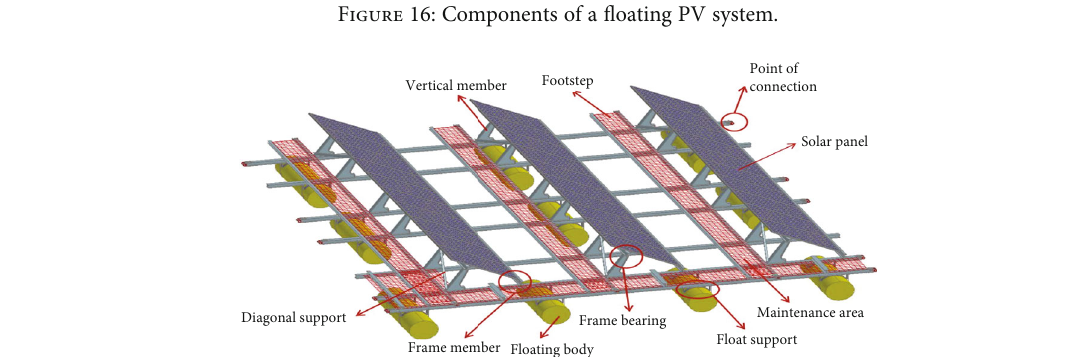
Figure 17: Frame array design of FPV fl oating platform [66].